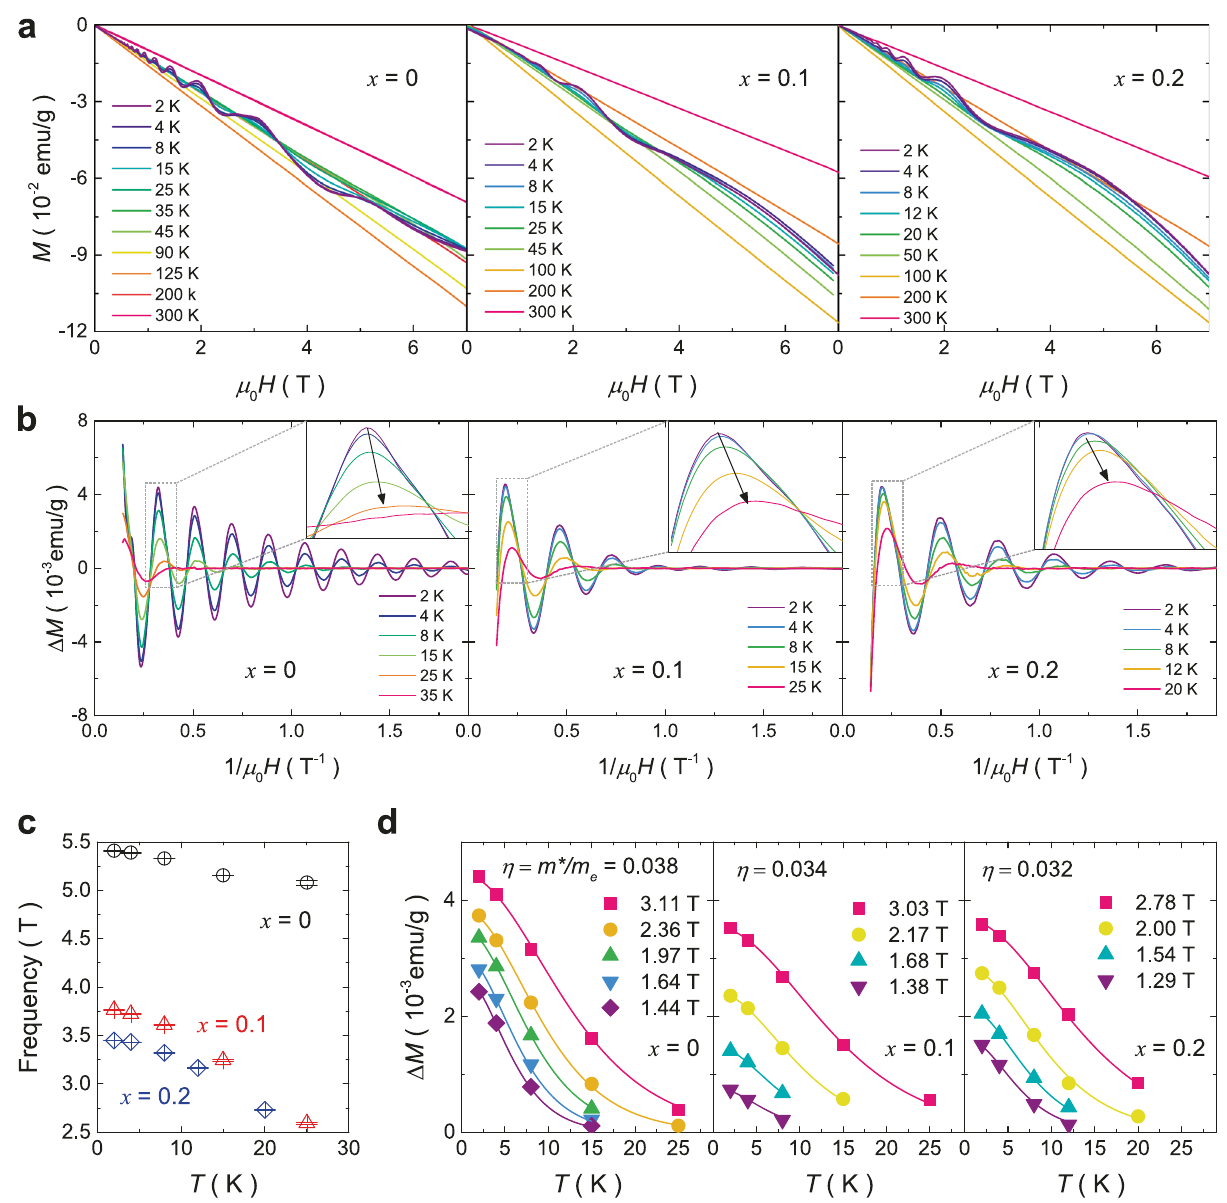
Fig. 4 Magnetization curves of three samples with a magnetic fi eld along the b axis. a Raw data of magnetization at various temperatures. b Oscillating component of each magnetization with subtracting smooth background in raw data. Magni fi ed single peaks are plotted to show the change of peak position clearly (inset). c Temperature-dependent quantum oscillation frequency. The error bars are the standard error of the Lifshitz – Kosevich formula fi t. d The fi t of the temperature reduction factor of quantum oscillations. The effective mass is the global parameter for fi tting the amplitudes at different magnetic fi elds. The evaluated effective mass ratio, η ¼ m (cid:3) = m , of the samples decreases with increasing x . The standard errors of the fi ts are provided as the error bars of the effective mass